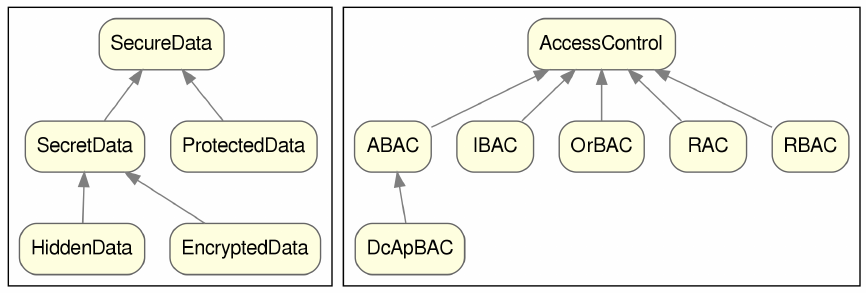
Figure 5. Class taxonomy. ( a ) SecureData class hierarchy. ( b ) AccessControl class hierarchy.